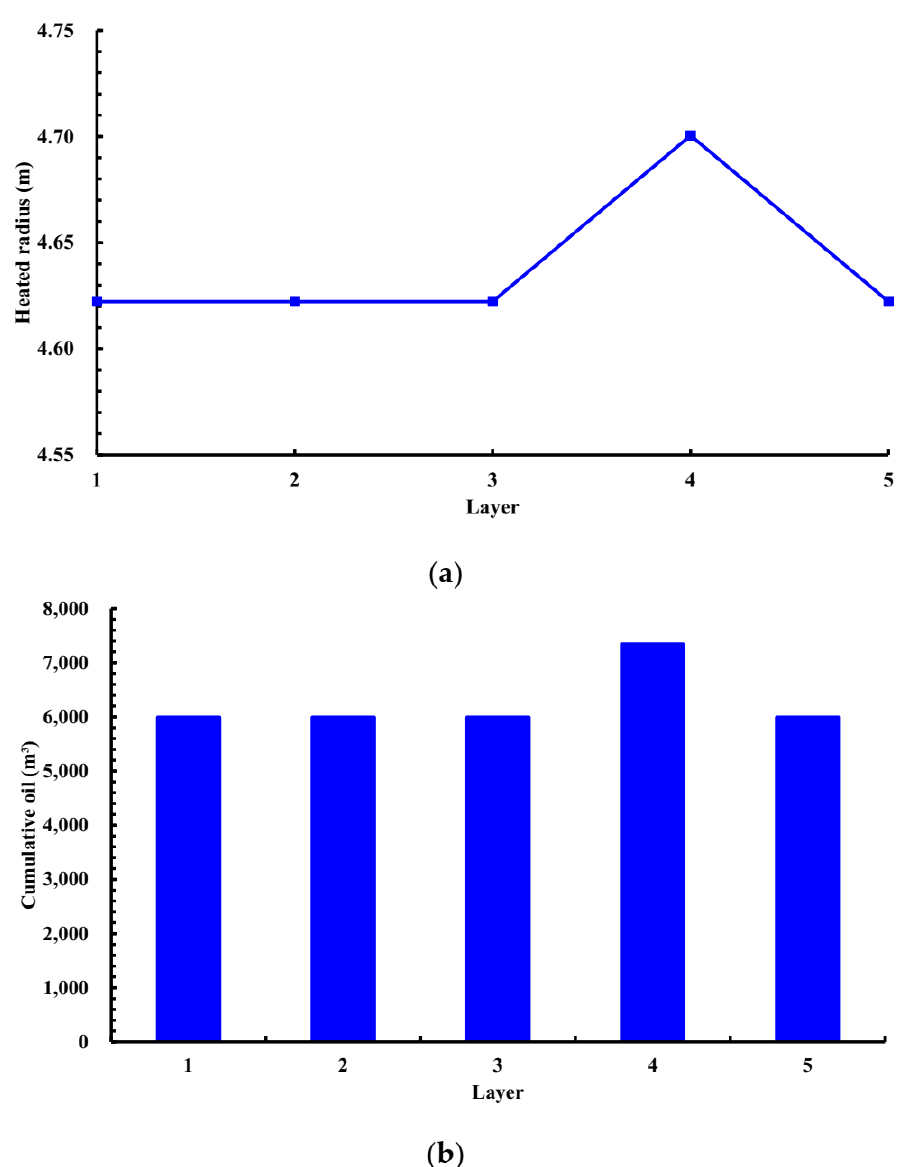
Figure 7. Simulation results for different formation layers—( a ) Heating radius; ( b ) Cumulative oil